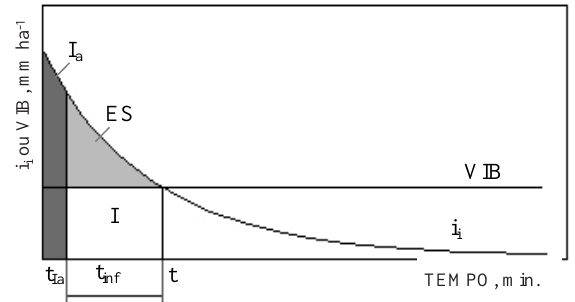
Figura 2. Componentes associados ao método proposto por Pruski et al. (1997); i = intensidade i instantânea de precipitação (mm h -1 ); VIB = velocidade de infiltração básica (mm h -1 ); Ia = abstrações iniciais (mm); ES = escoamento superficial (mm); I = infiltração (mm); t = tempo Ia em que ocorre as abstrações iniciais (min); t = tempo de duração da precipitação para o qual a lâmina de escoamento é máxima (min); e t = tempo de duração da infiltração inf